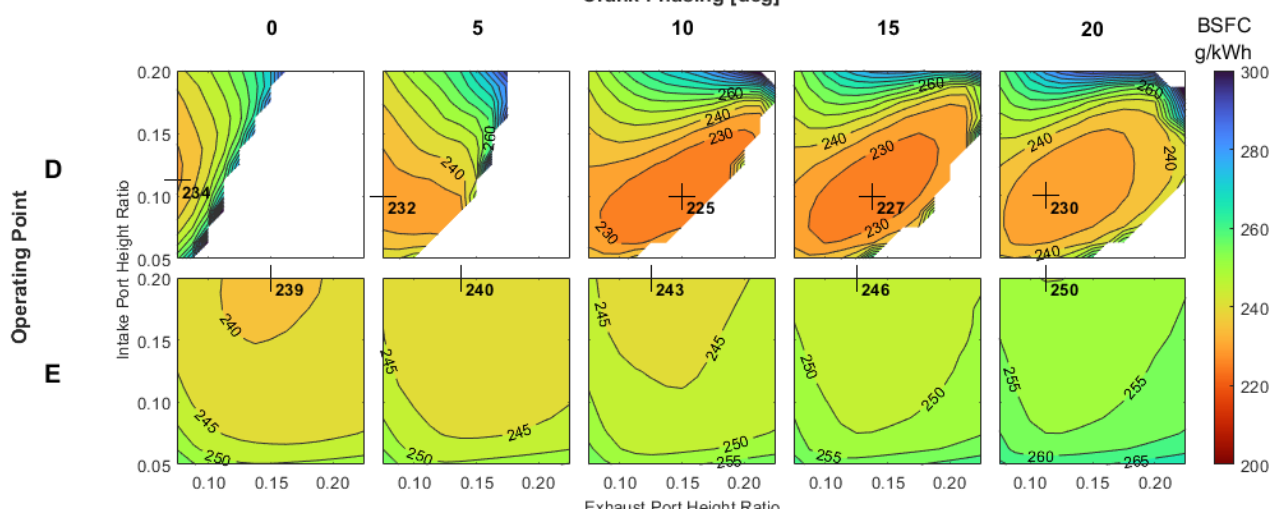
Figure 14. Variation in BSFC with crankshaft phasing and intake and exhaust port height-to-stroke ratio at operating points D and E (1500 min − 1 , 16-bar BMEP and 3000 min − 1 , 8-bar BMEP, respectively); λ = 1. White space indicates inoperable regions. All BSFC contours are drawn at intervals of 5 g/kWh.